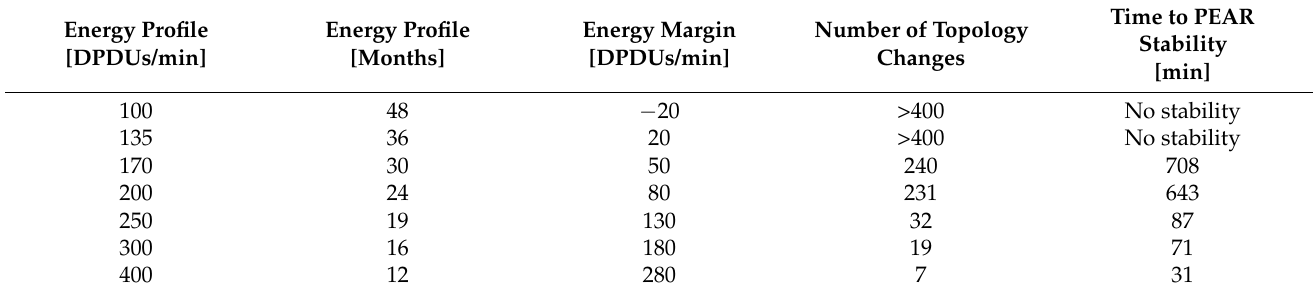
Table 2. The number of topology changes and the time to stability.